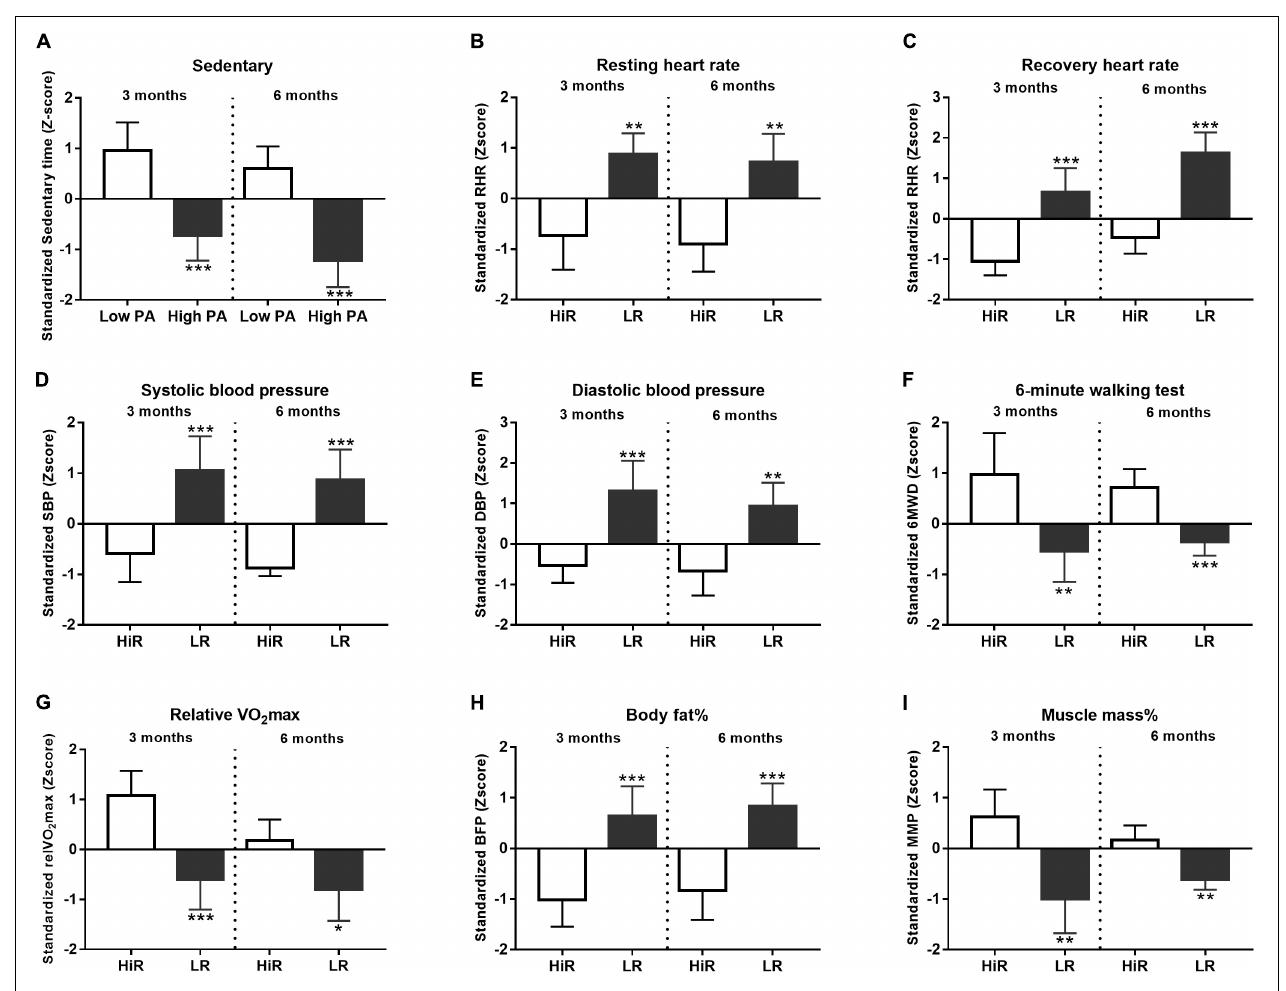
FIGURE 1 | Individual variation of physiological parameters in response to lifestyle program. (A–I) K-means cluster analysis was used to differentiate high- (HR) and low (LR) responders ( n = 14). Bar graph values indicate standardized Z-score values, and standard deviation values. 3- and 6-month values were normalized to baseline values and converted to Z-scores. ∗ Significant difference between HR and LR ( p < 0.05). ∗∗ Significant difference between HR and LR ( p < 0.01). ∗∗∗ Significant difference between HR and LR ( p < 0.001). Please refer to Supplementary Material S1 for exact numerical